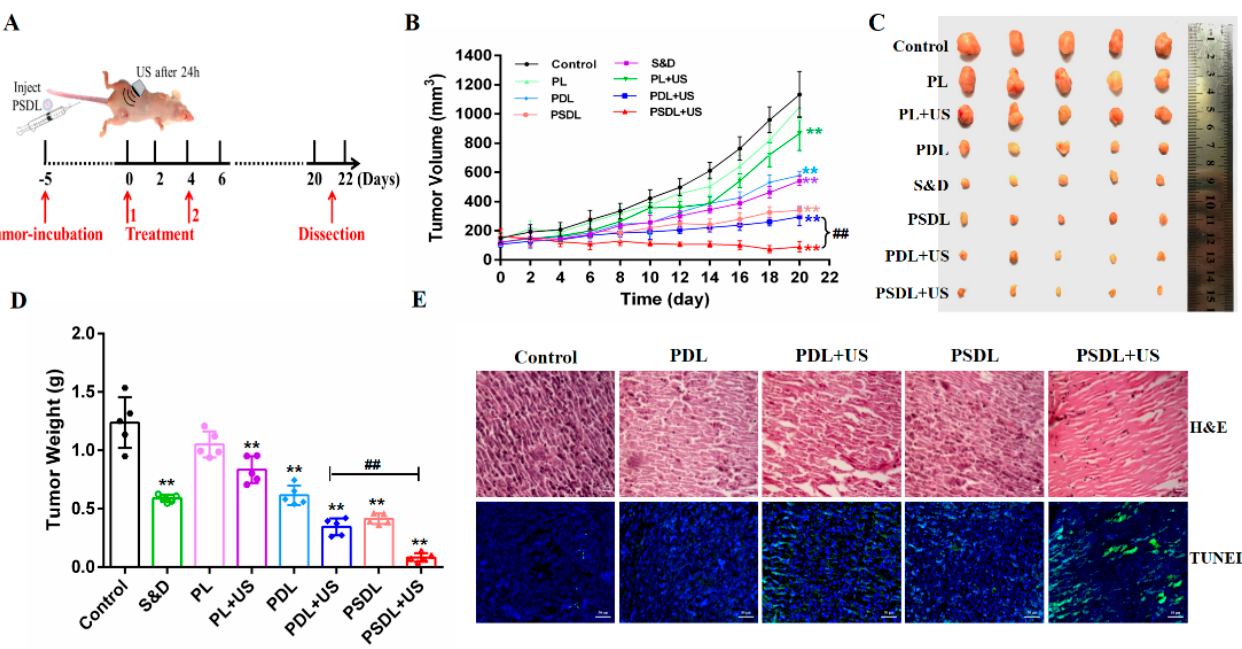
Figure 6. Antitumor assessment in vivo. ( A ) Schematic illustration of sequence of treatment in vivo; ( B ) tumor growth curves of MDA-MB-231 tumor-bearing nude mice after different treatments; ( C ) tumor photos of different groups; ( D ) average tumor weight inhibition ratio of mice in each treatment group; ( E ) H&E staining in MDA-MB-231 tumors (scale bar = 20 µ m) and TUNEL staining in MDA-MB-231 tumors (scale bar = 50 µ m). ** p < 0.01, compared with control; ## p < 0.01, compared among groups.